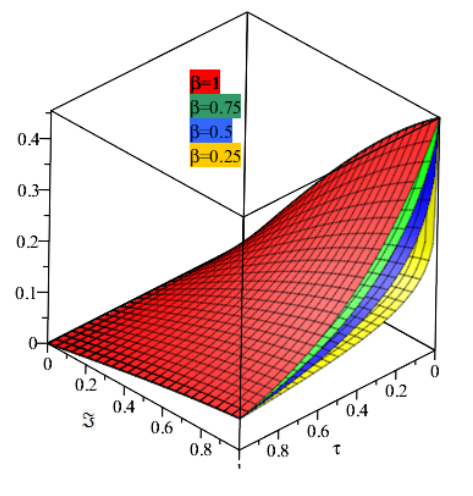
Figure 6. Represents the analytical solution of Example 2 at β = 1.